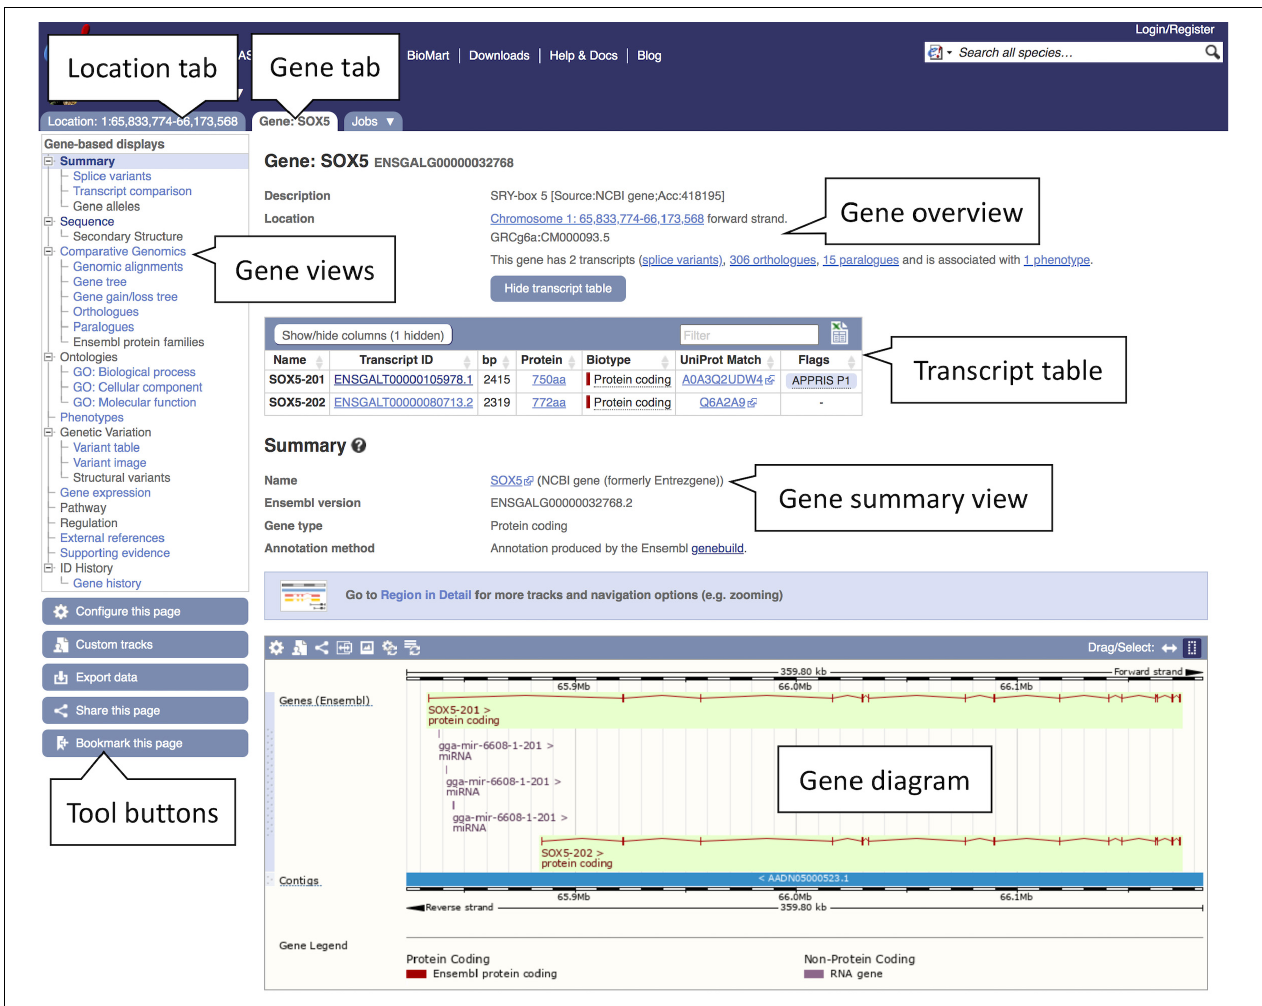
FIGURE 2 | Gene view of SOX5 . The gene view tab shows a variety of information about the gene including details on the location, transcripts, orthologues, and paralogues. The main gene track is shown in the bottom panel with red blocks representing the exons and connecting red lines representing the introns. In this example a secondary track for liver transcriptomic data can be seen in blue. This and other tissue tracks are available via the “Configure this page” option in the left-hand